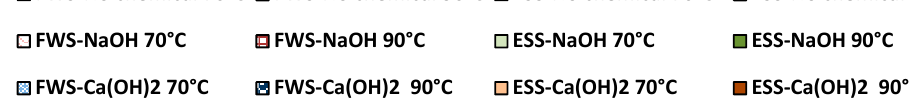
Figure 7. The changes in the sCOD of the non-pretreated, chemically, and thermochemically pretreated excess sewage sludge and food waste slurry. (Chemicals: NaOH and Ca(OH) 2 , temperatures: 70 and 90 °C).